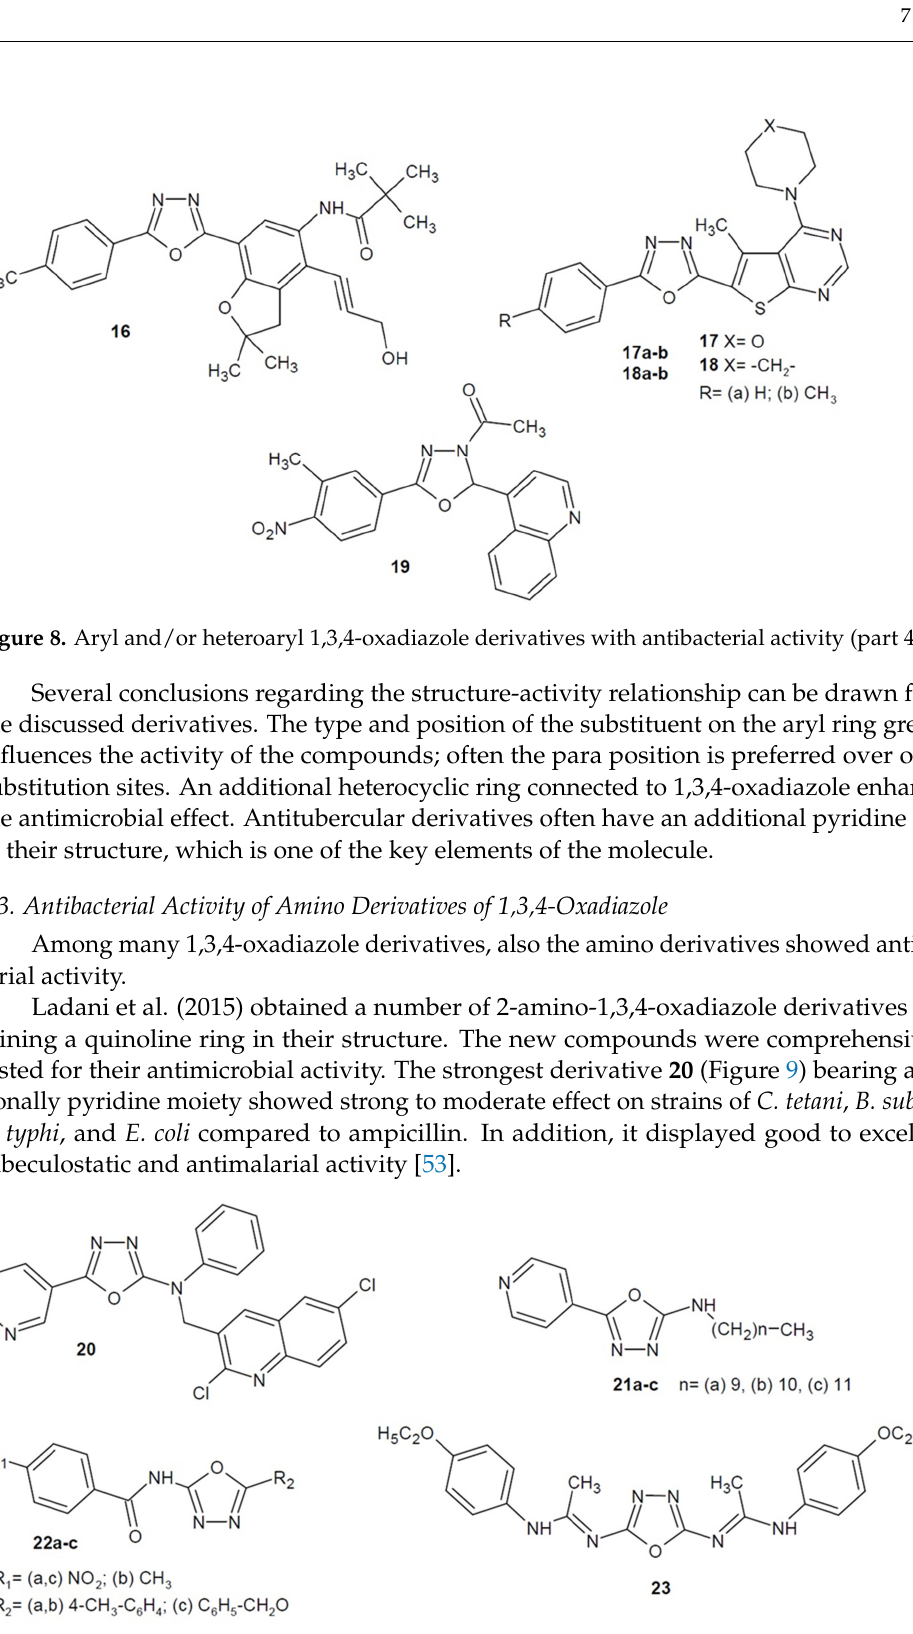
Figure 9. Amino-1,3,4-oxadiazole derivatives with antibacterial activity (part 1).